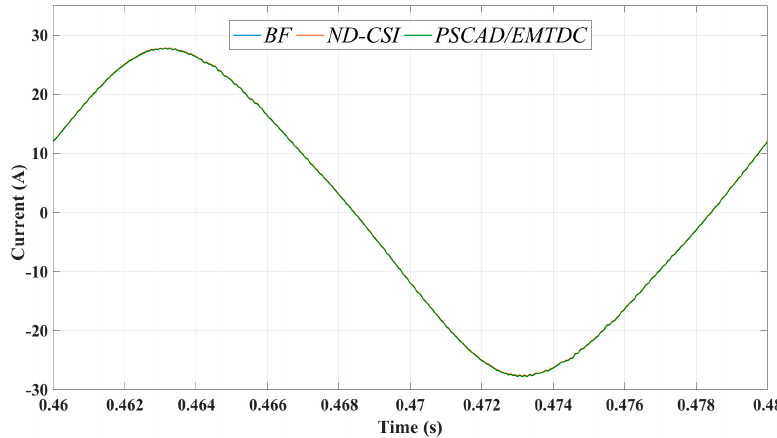
Figure 10. Periodic steady state current waveform at PCC.